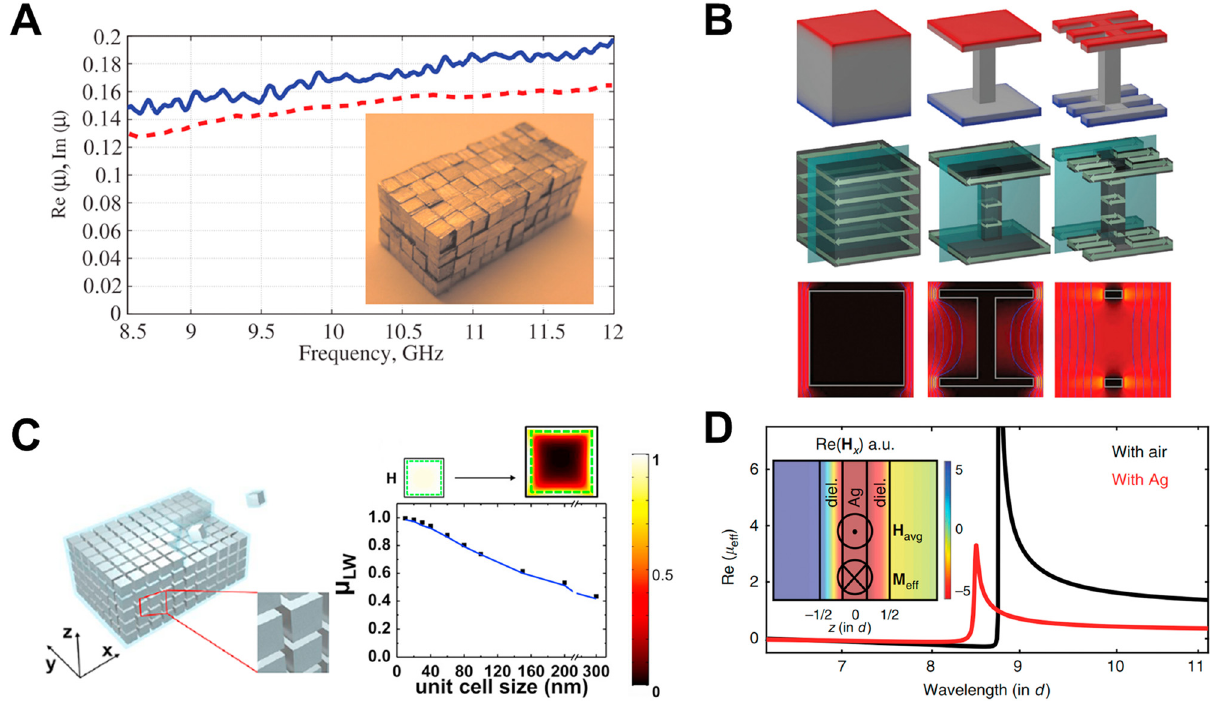
Figure 4: Metamaterials with near dispersion-less effective magnetic permeability. (A) A μ -near-zero metamaterial composed of metallic cubes and measured permeability. Adapted with permission from Ref. [49]. Copyright 2013, AIP Publishing. (B) The principle of independent controlof permittivityandpermeability is illustratedthrough threemotif designs.Each columncorresponds to a differentmotif that produces a similar effective permittivity but progressively larger effective permeability from left to right. The fi rst row shows induced surface charges from the capacitive coupling between metallic inclusions. The second row shows eddy currents and the third row shows magnetic fi